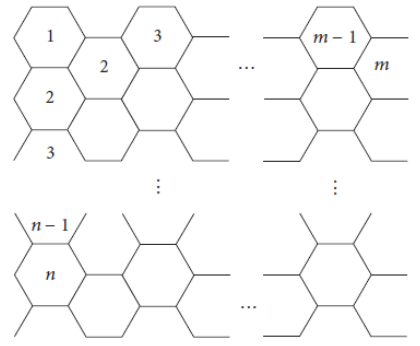
Figure 3. The 3D lattice of the armchair TUAC 6 [ m , n ]